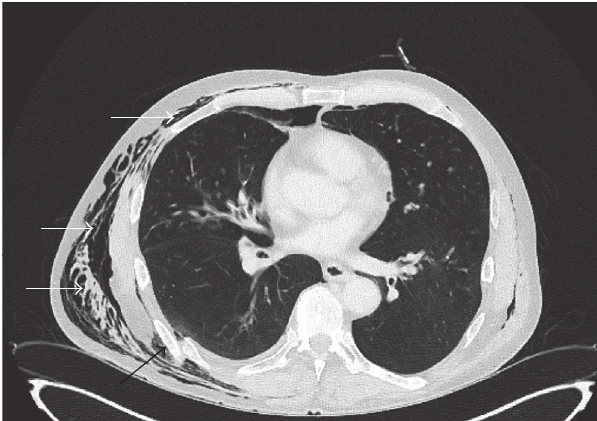
Figure 2: The image shows a displaced fracture of the 7th rib (black arrow). White arrows outline diffuse thoracic subcutaneous emphysema of the lateral chest